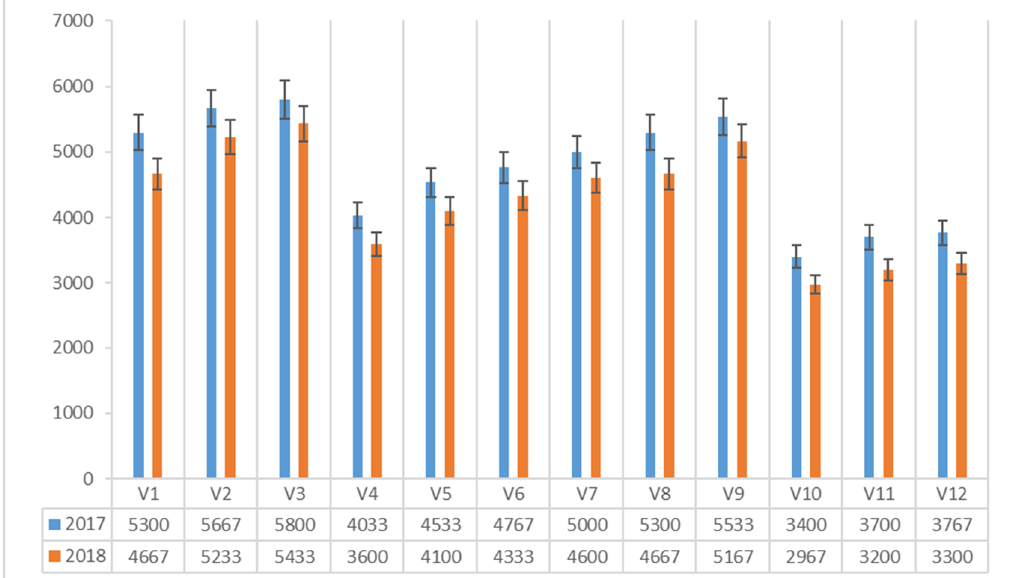
Figure 4. Vitamin B 2 vitamin content of Agaricus blazei Murrill mushrooms ( µ g 100 g − 1 dm) in two years of